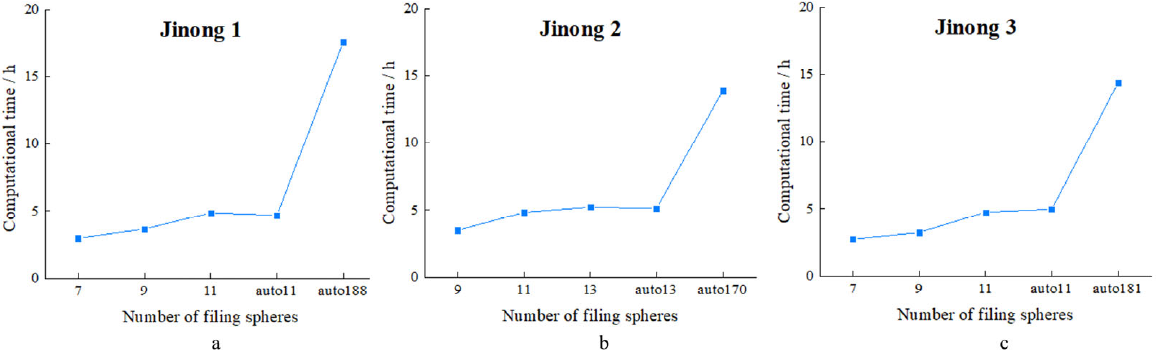
Figure 20. Computational times of the bulk density test simulation.